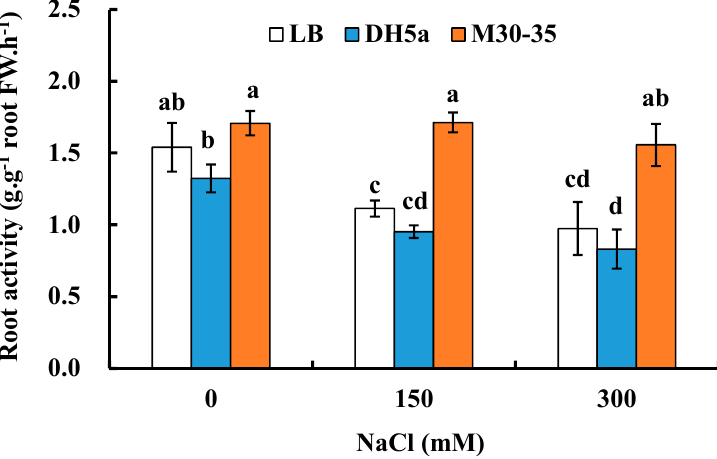
Figure 3. Effects of M30-35 on root activity of ryegrass under salt treatment (0, 150 and 300 mM NaCl). Values are means and bars indicate SEs ( n = 12). Columns with different letters indicate significant differences among treatments at p < 0.05 (ANOVA and Duncan’s multiple comparison test).